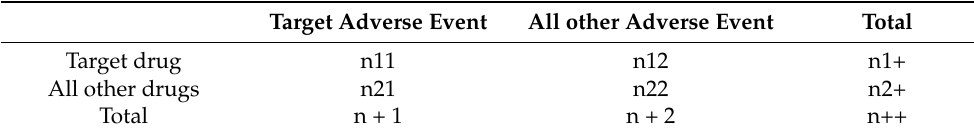
Table 5. 2 × 2 Contingency table for disproportionality